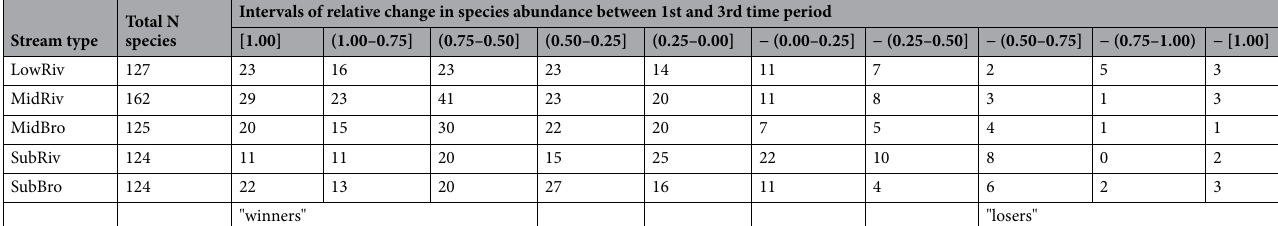
Table 2. Number of species recorded in each of five stream types and classified based on their relative change in their mean abundance between 1997–2000 (period 1) and 2015 (period 3) into intervals. Species appearing in the intervals [1–0.5] were arbitrary considered “winners” and “losers”. For calculations of the relative change and detailed species distributions see Supplements to Methods and Supplementary Fig.